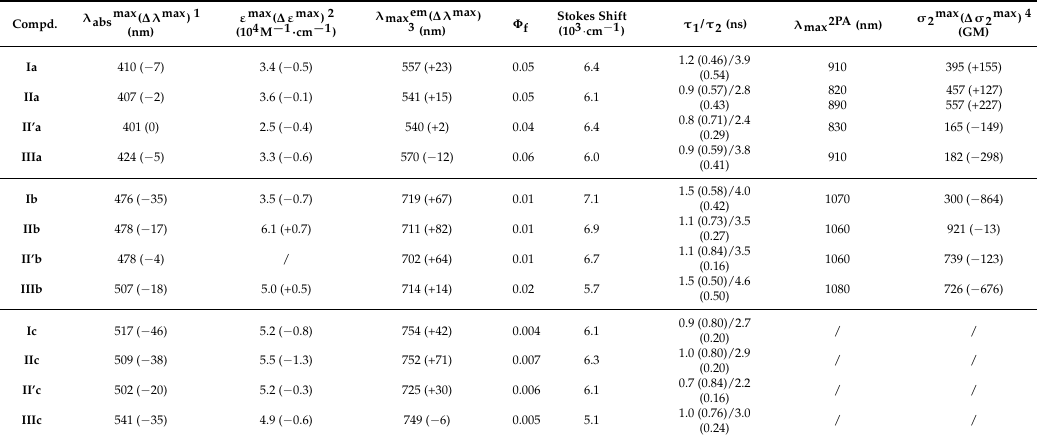
Table 4. One-photon and two-photon photophysical data of dyes I – IIIa – c as FONs chromophoric subunits in deionized